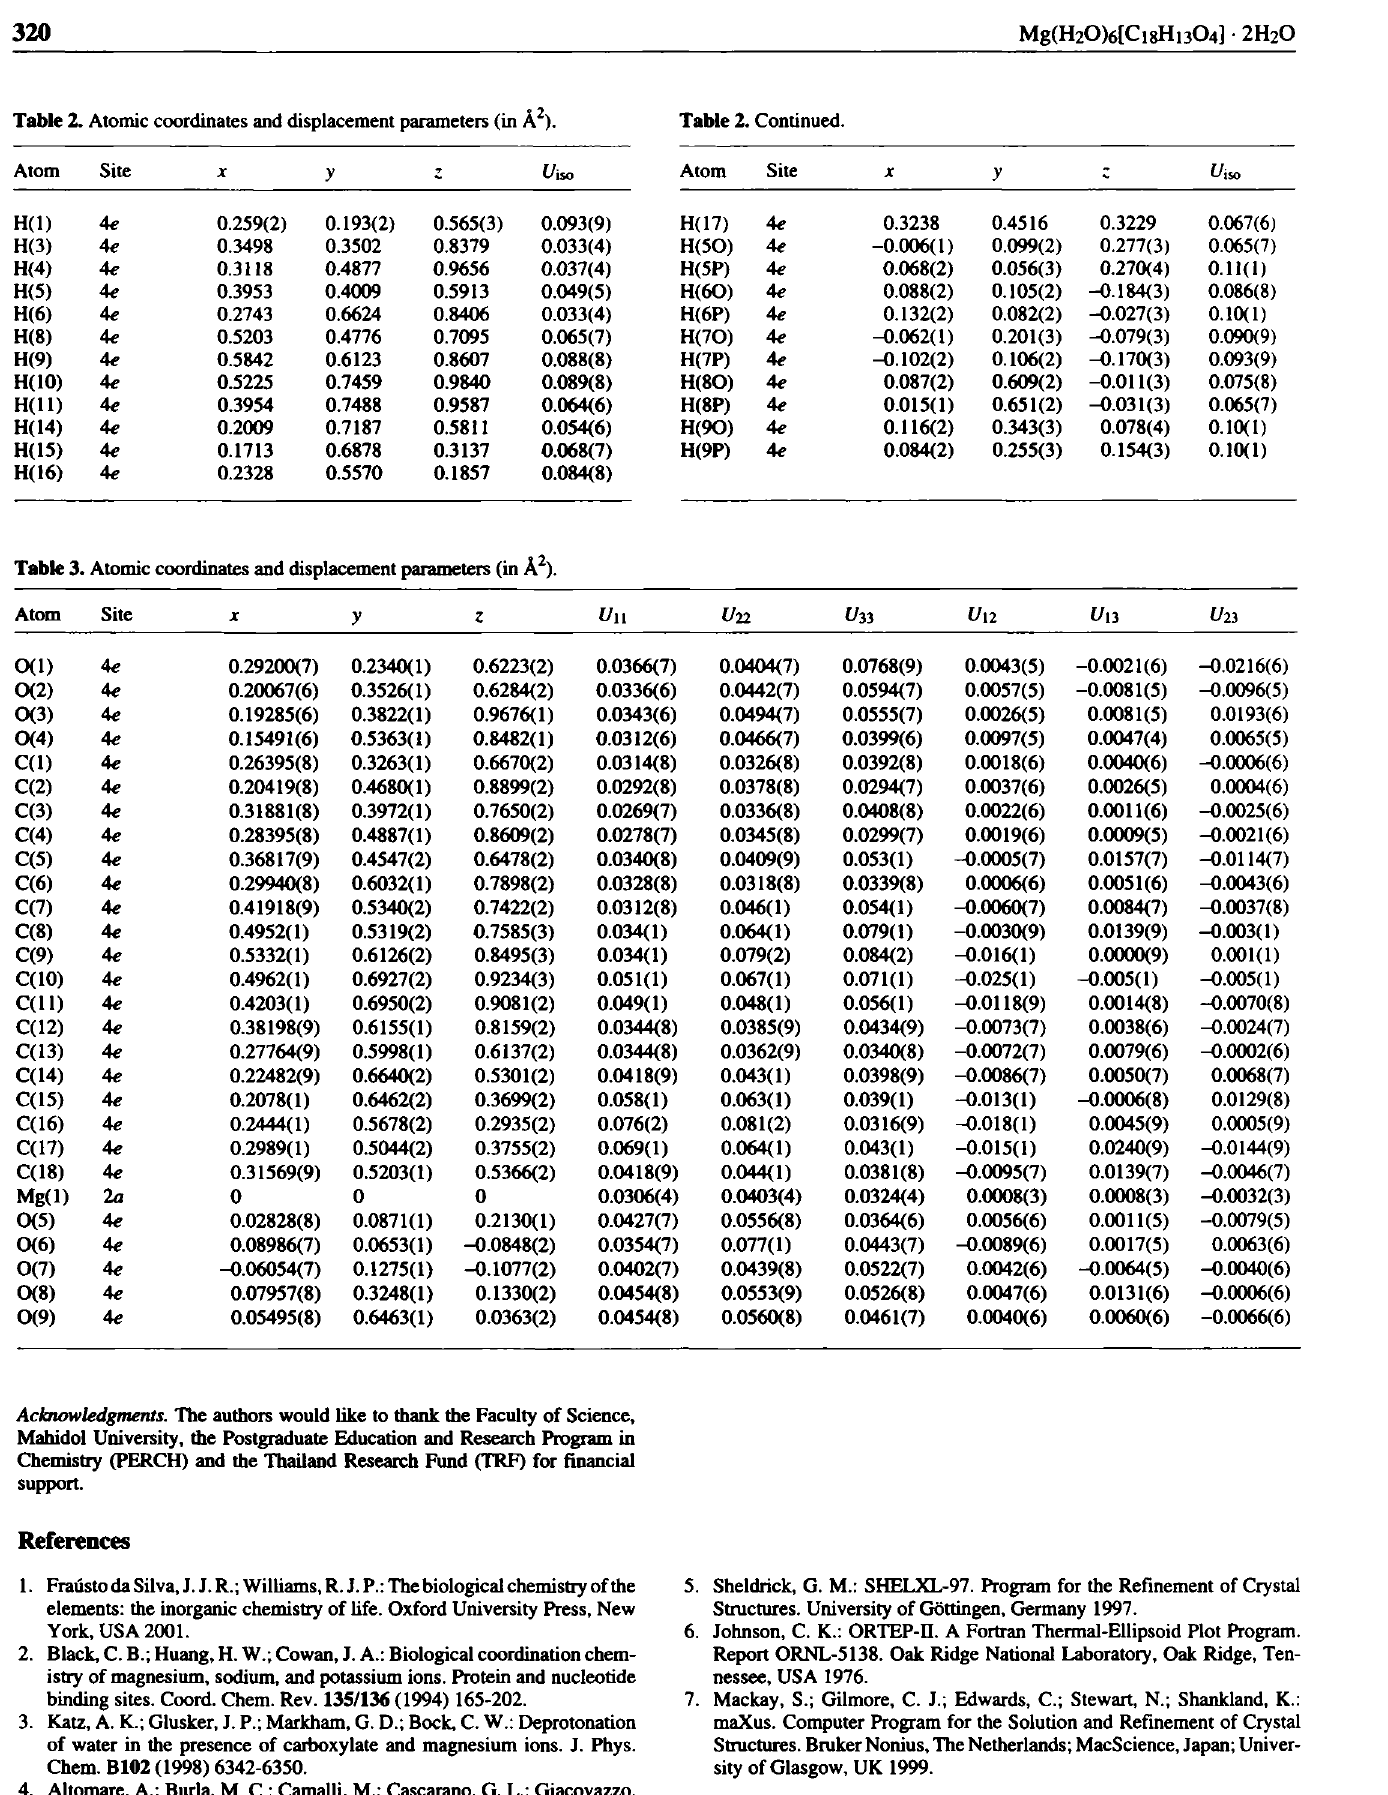
Table 2. Atomic coordinates and displacement parameters (in Â 2 ). Table 2. Continued.